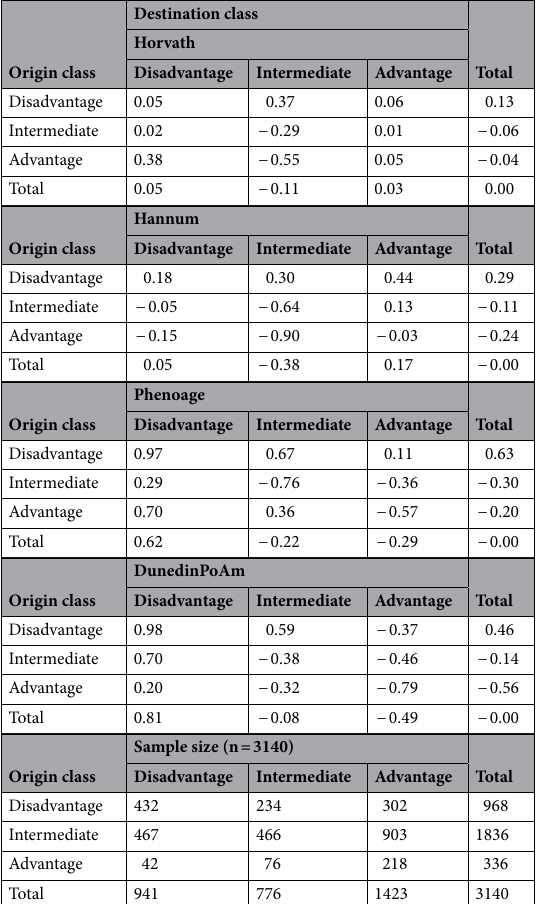
contribution of childhood social class to DunedinPoAm AA of mobile groups is lower than the